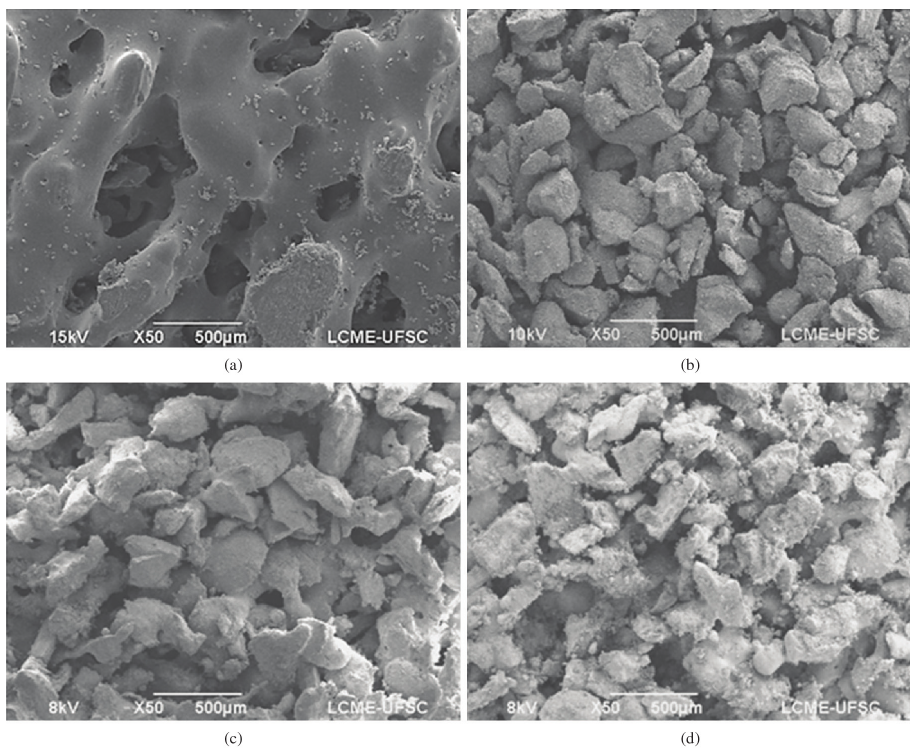
Figure 8. Micrographs with 50x of magnification. a) pure polymer; b) polymer with 10%wt of BG; c) polymer with 20%wt of BG; d) polymer with 30%wt of BG.